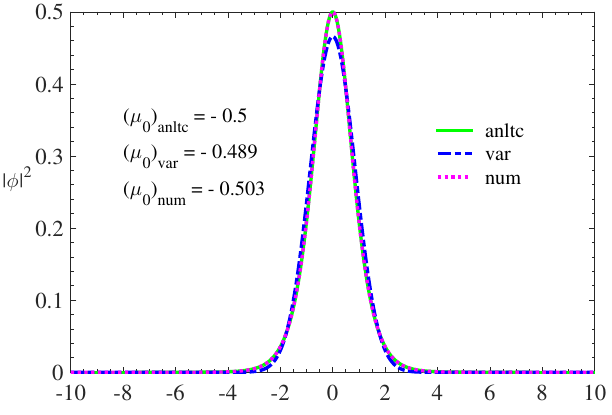
Figure 1. Comparison of variational and numerical results with the analytical solution of Equation (16) for V 0 = 1/2 and g = 1. The analytical solution, represented by the continuous curve (green), is given √ (cid:16) (cid:17) by the expression φ ( x ) = 1/ 2 sech ( x ) . The variational solution, represented by the dashed curve √ (cid:0) − (cid:1) π 1/2 w exp (blue), was obtained using the Gaussian ansatz φ ( x ) = 1/ 0.5 x 2 / w 2 whose width, w , obtained by Equation (14) was w = 1.211. The numerical solution, represented by the dotted curve (magenta), was obtained through the propagation of imaginary time using the Gaussian function (cid:112) (cid:0) − (cid:1) π 1/2 w 0 exp 1/ 0.5 x 2 / w 2 as an initial condition. Here, labels “anltc”, “var”, and “num” represent 0 analytical, variational, and numerical results,